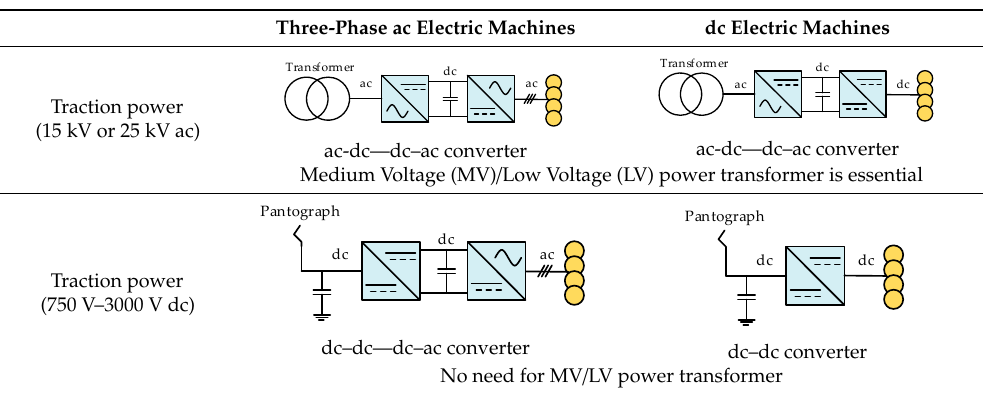
Table 5. Power electronics for traction machine applications in railway systems.